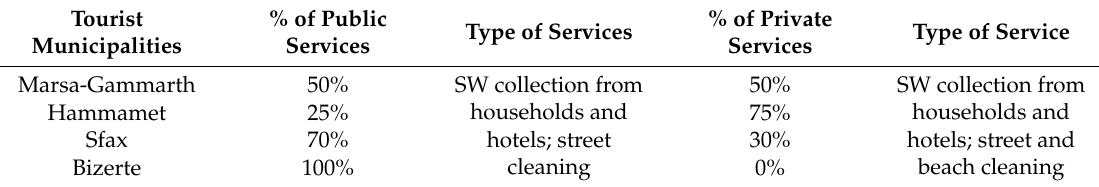
Table 4. Intervention of private and public sectors in waste management (WM) services (%).